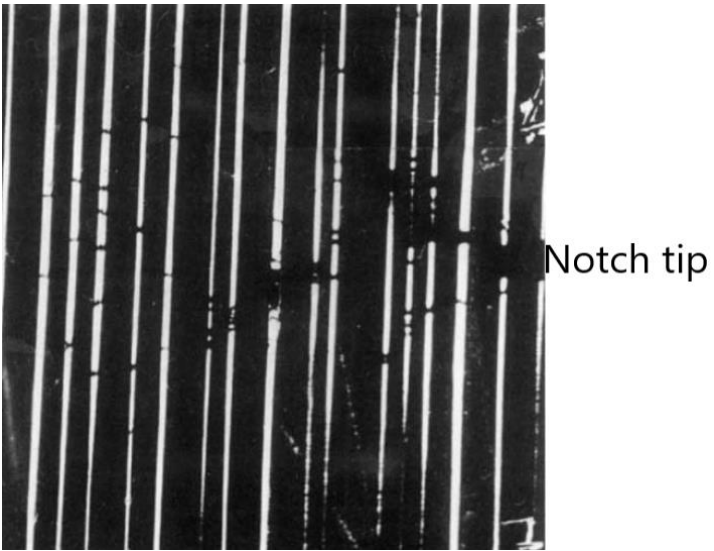
Figure 2. Multiply fibre breakage at the notch tip in boron/aluminium composite.